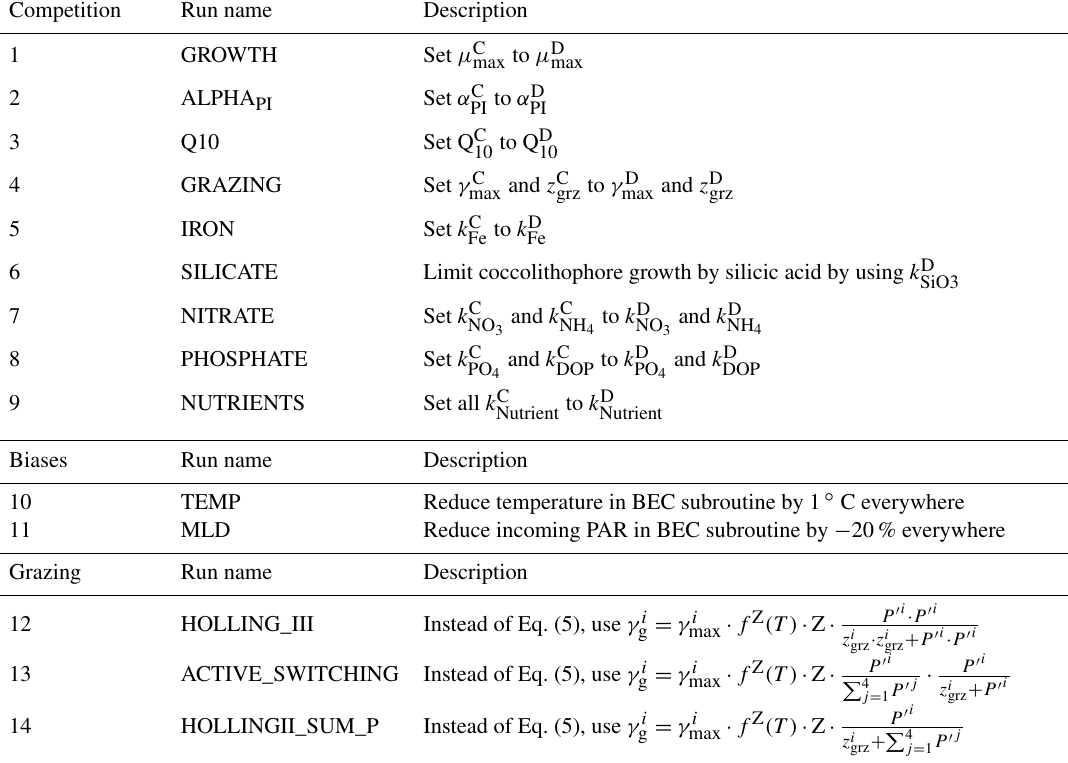
Table 2. Overview of sensitivity simulations. 1–9: sensitivity of simulated coccolithophore–diatom competition to chosen parameter values of coccolithophores. See Table 1 for parameter values of coccolithophores in the reference run. 10–11: sensitivity of simulated biogeog- raphy to biases in temperature and mixed layer depth. 12–14: sensitivity of simulated biogeography to the chosen grazing formulation. C: coccolithophores, D: